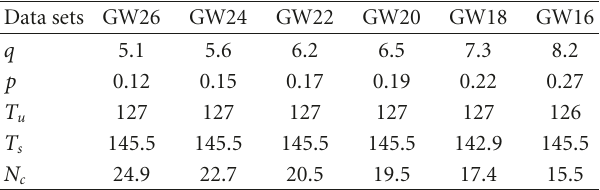
Table 3: Estimated parameters for CP-OFDM signals using real data measurements.